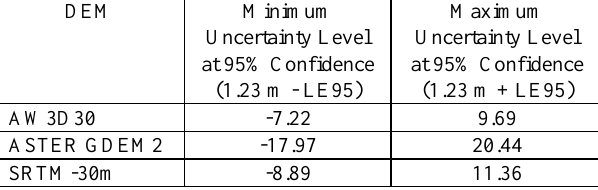
Table 4. Minimum and maximum uncertainty levels for mapping potential inundation for an accumulated SLR of 1.23 m for the year 2100. Values are based on the use of all GCPs in vertical uncertainty analysis. All values are elevation in meters referred from EGM96 datum.